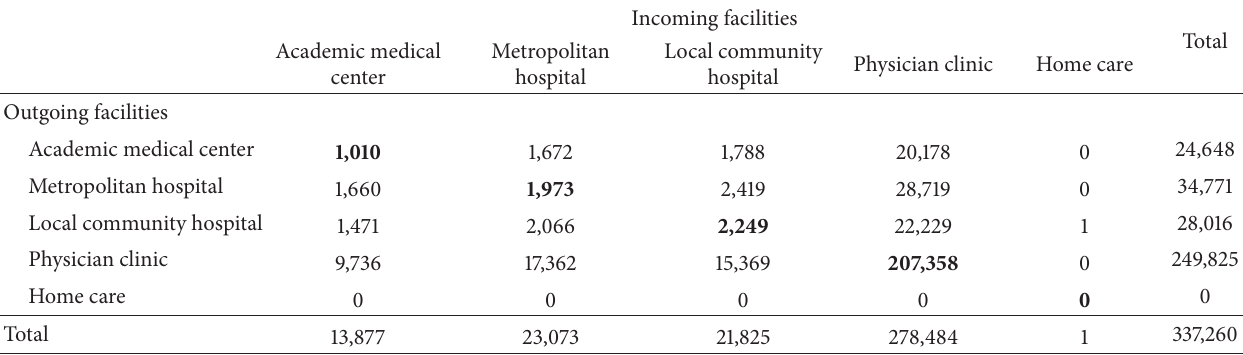
Table 2: Distribution of a patient’s switches ( n = 337,260) between different healthcare facilities within one day in the 1,000,000-person cohort in 2010, stratified by accreditation level of healthcare